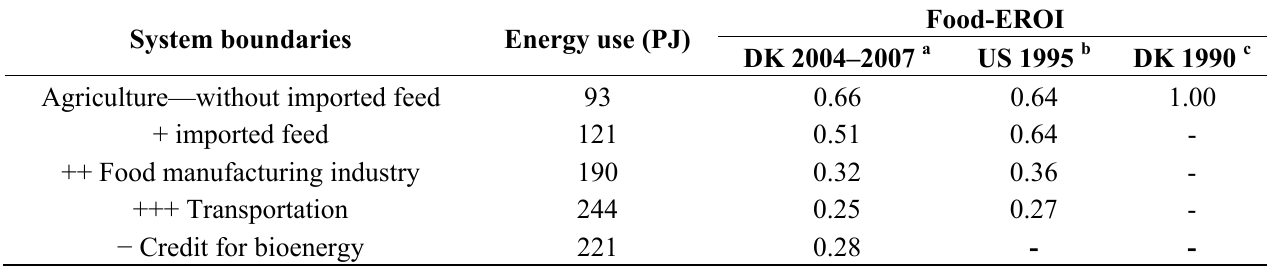
Table 6. Direct and indirect fossil energy use and Food-EROI for accumulated compartments of the Danish food production system and Food-EROI for comparable